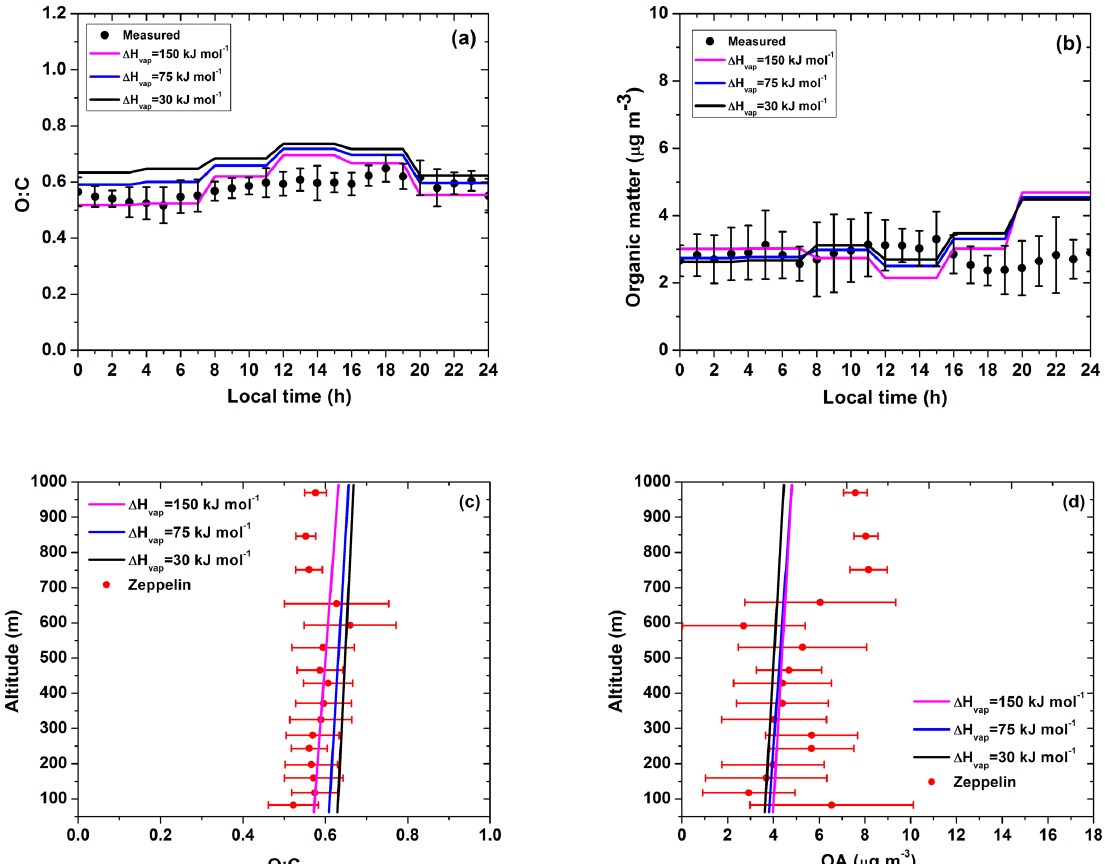
Figure 6. Diurnally averaged (a) O : C ratios and (b) organic aerosol mass concentrations. Average vertical organic aerosol (c) O : C and (d) organic aerosol mass concentrations assuming in the model (cid:49)H vap = 30kJmol − 1 (black line), (cid:49)H vap = 75kJmol − 1 (blue line), and (cid:49)H vap = 150kJmol − 1 (magenta line) for the Po Valley in Italy. The black symbols show the ground AMS measurements. The red symbols show the Zeppelin measurements. The error bars represent 1 standard